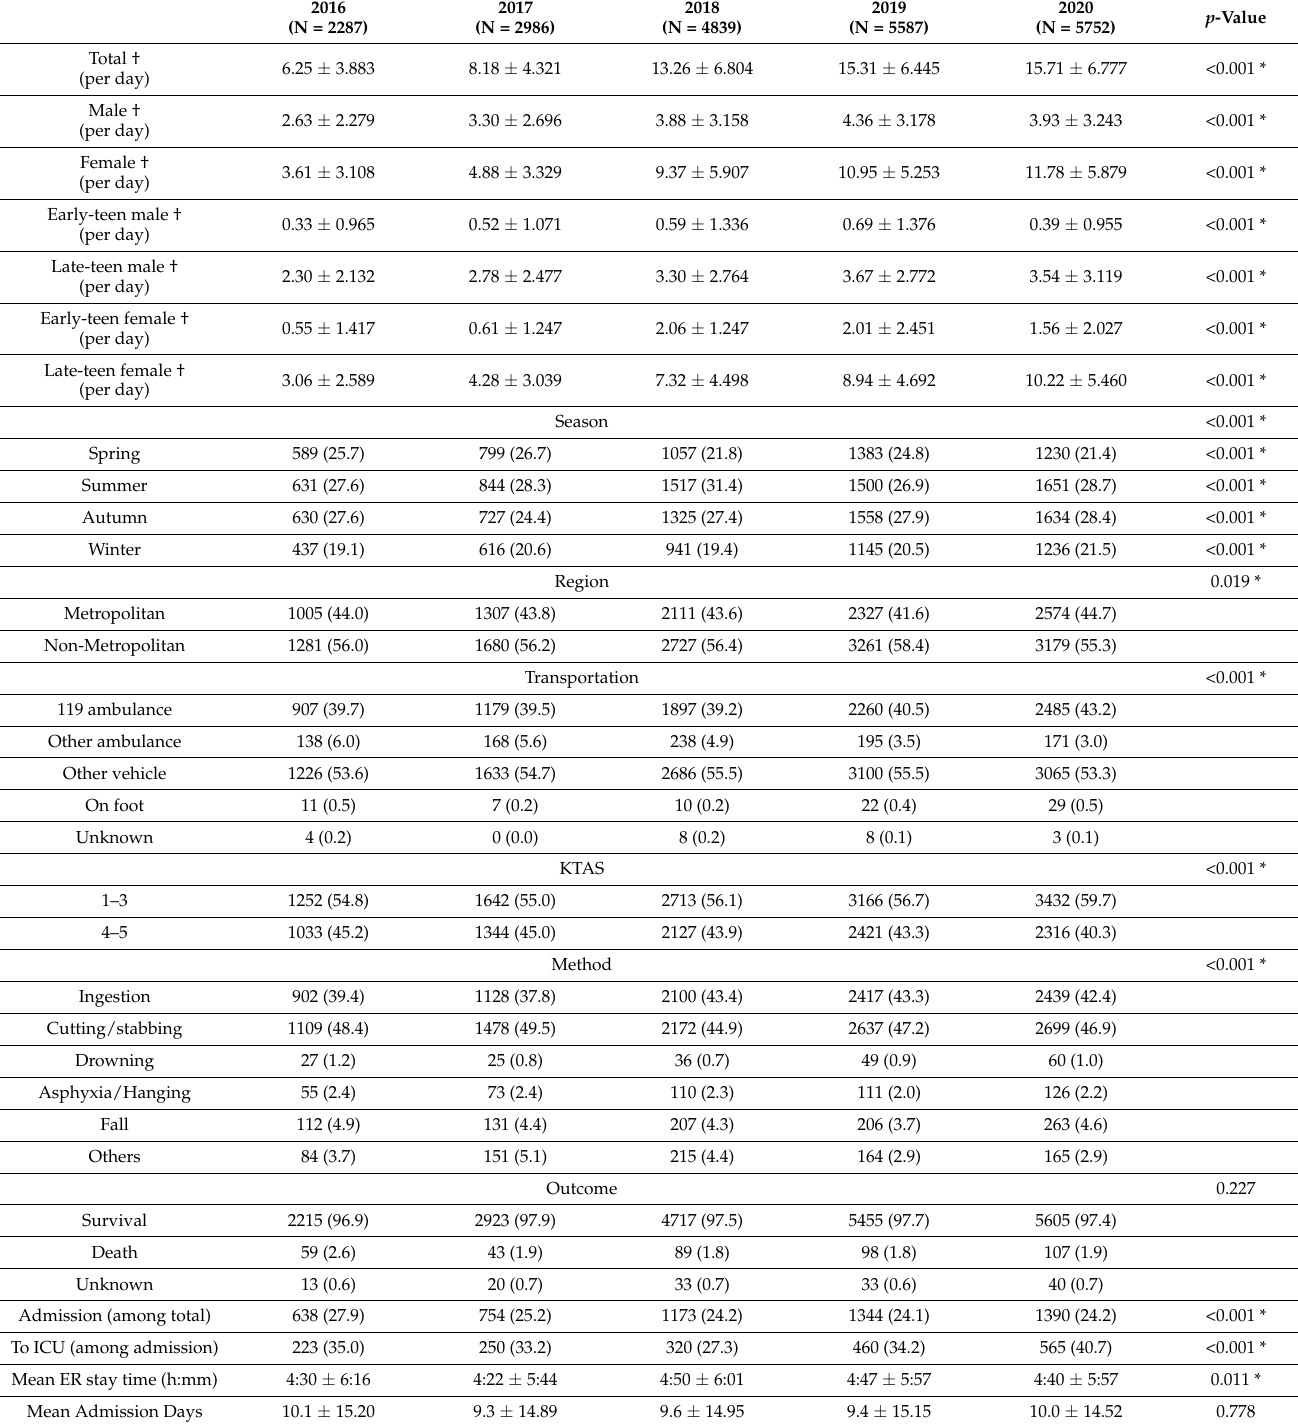
Table 1. Comparison of patients who visited an emergency department for self-harm in Korea